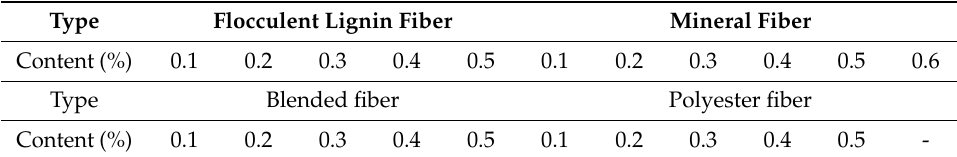
Table 8. Different fiber types and fiber content in SMA